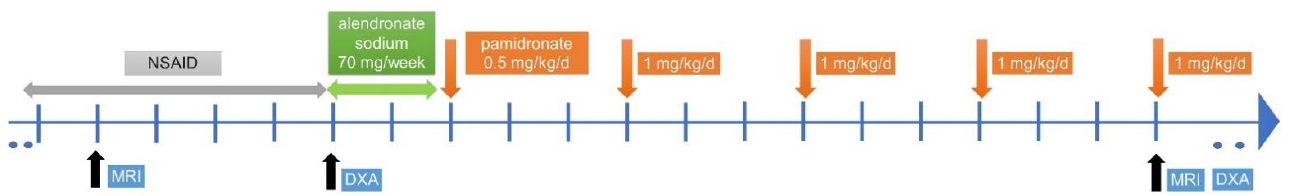
Figure 3. A timeline of therapeutic interventions (months). DXA, dual-energy X-ray absorptiometry; NSAID, non-steroid anti-inflammatory drug; MRI, magnetic resonance imaging.